Question: Is the quantity shown trending increasing or decreasing?
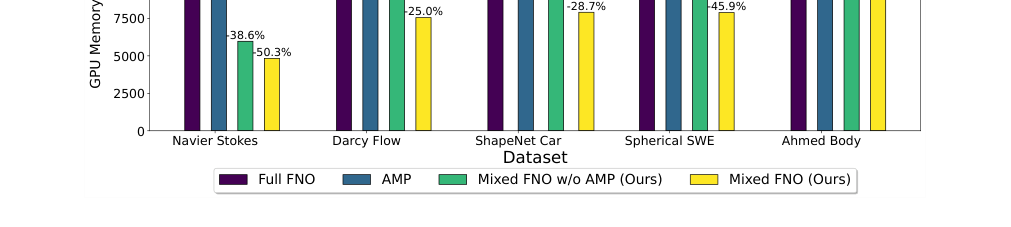
Answer: decreasing